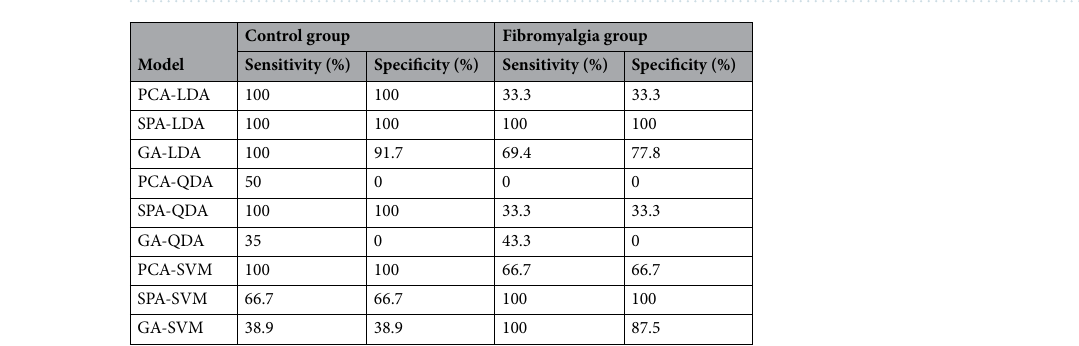
Figure 2. PCA scores on PC1 versus PC2 for samples from the control group and the FM group, with confidence ellipse in each group. The percentage of total variance is described for each PC (in parentheses). The blue dotted circle represents a 95% confidence level.